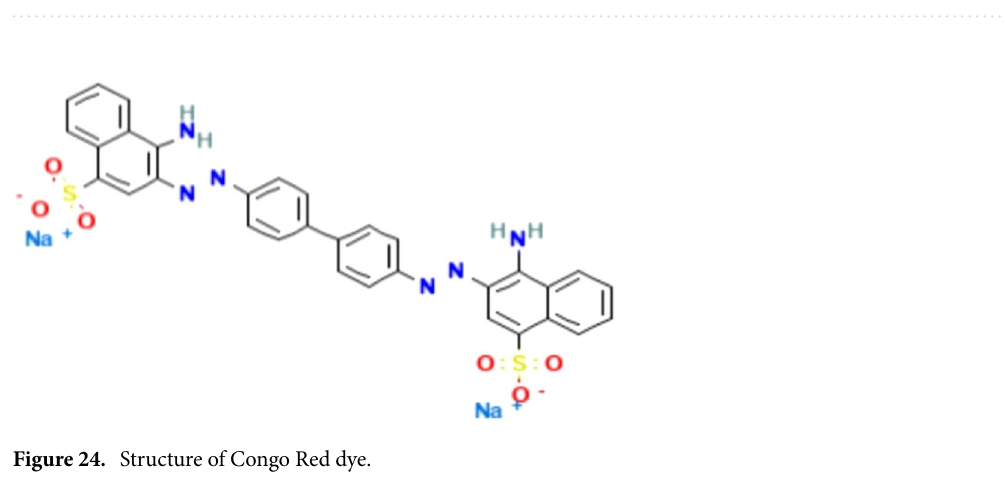
Table 6. Comparison between FA and other adsorbents.